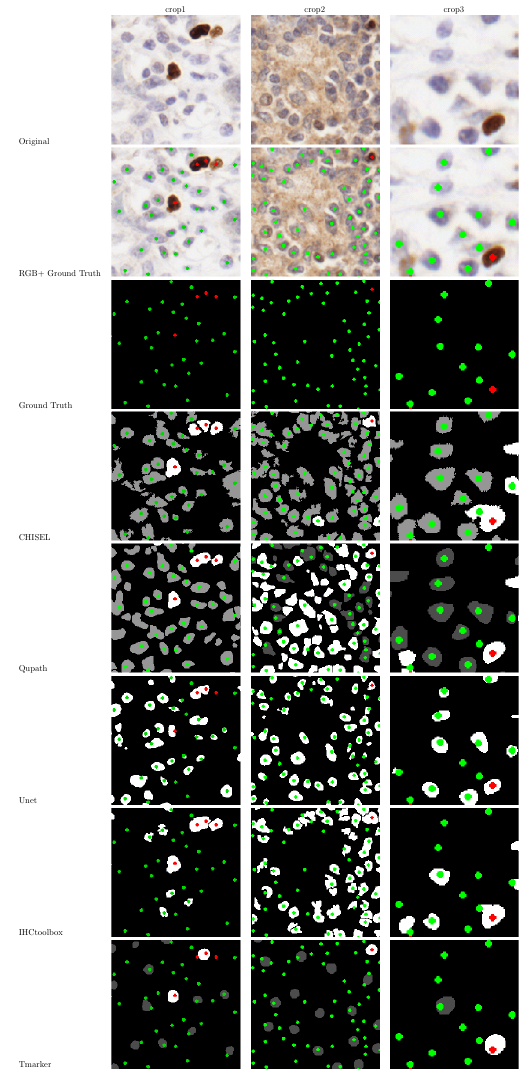
Figure 7. Visual comparison of specific results of five different methods. Ground Truth: green labels = immunonegative nuclei; red labels = immunopositive nuclei. In results: gray area is an object classified as immunonegative; white area is an object classified as immunopositive. The IHCtoolbox and Unet methods allowed only the detection of nuclei, and hence, all the objects are presented as white.